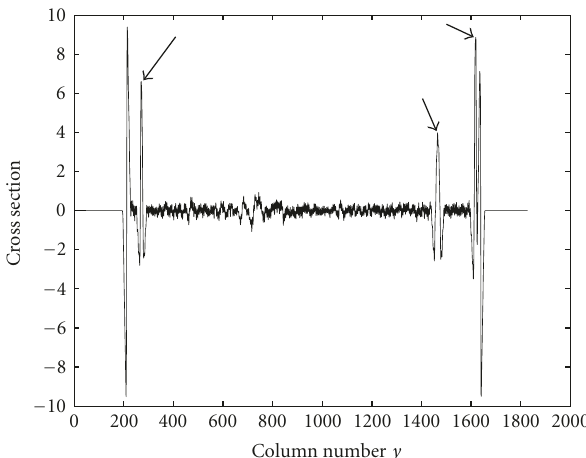
Figure 3: Horizontal cross section of the scratched image in Figure 2. Scratches are indicated by arrows. Their impulsive nature is evident.